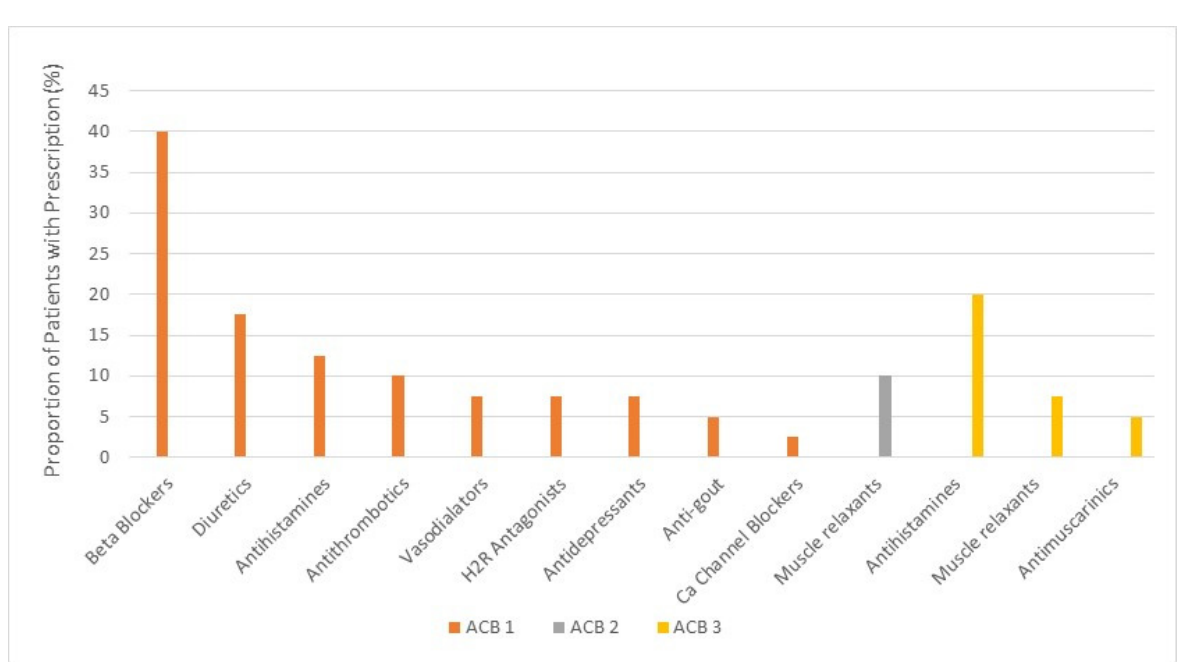
Figure 1. Most frequently prescribed medication classes by anticholinergic cognitive burden score. ACB = anticholinergic cognitive burden; H2R = histamine type 2 receptor. antihistamine ACB 1 = cetirizine, loratadine, desloratadine; antihistamine ACB 3 = diphenhydramine, hydroxyzine; muscle relaxant ACB 2 = cyclobenzaprine; muscle relaxant ACB 3 = Table 2. Frequency of all prescribed medications, overall and in patients with low vs. high anticholinergic burden.